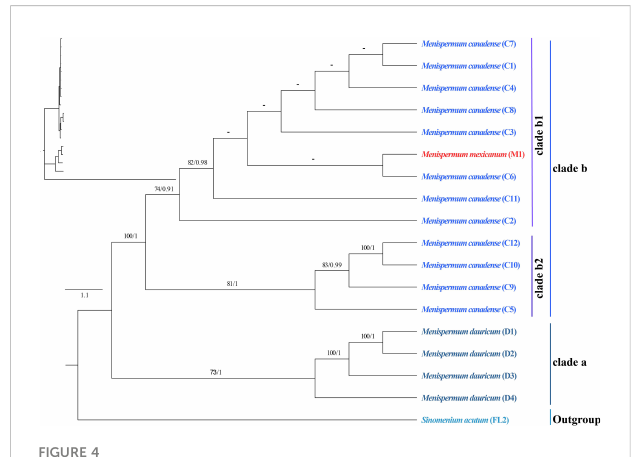
FIGURE 4 Maximum likelihood (ML) and Bayesian inference (BI) phylogeny based on 17 ITS1&ITS2 sequences of Menispermum , with Sinomenium as outgroup. Numbers at each node represent ML bootstrap support (BS) and BI posterior probability (PP) values, respectively. Hyphens indicate the nodes not found in the strict consensus BI tree. The phylogram on the upper left shows the relative branch lengths. Sample codes are the same as in Table 1.